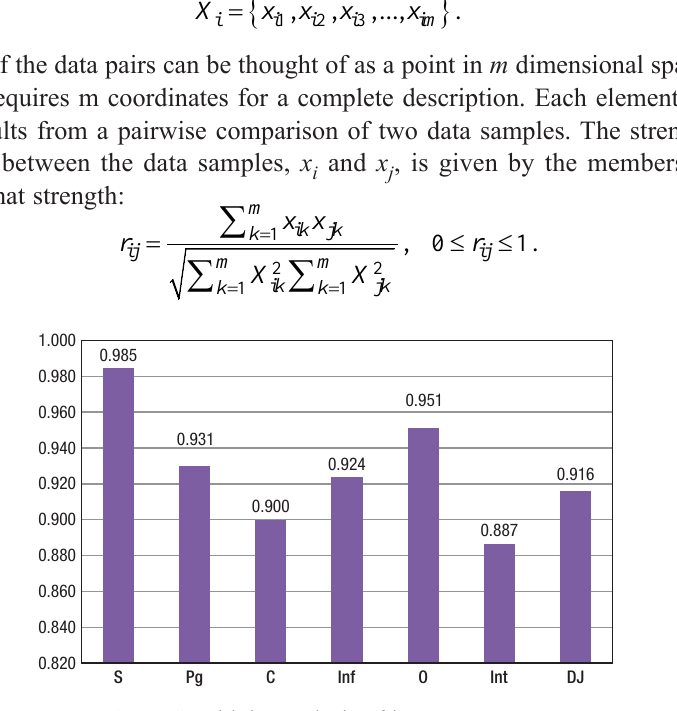
Fig. 8. Sensitivity analysis of input